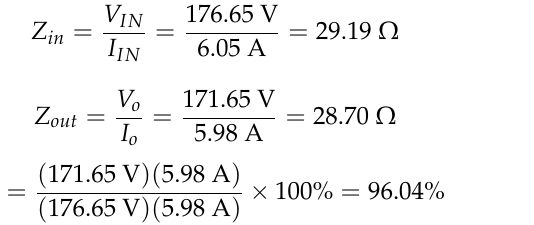
Figure 20. Input voltage (blue), output voltage (blue), input current (red), and output current (green), P o = 1 kW. In Figure 20, an output voltage of 171.65 V rms is obtained for an input voltage of 176.65 V rms , where G V = 0.97 with input and output currents of 6.05 A and 5.98 A, respectively, obtaining G I = 0.988. With the values V in , V o , I in , and I o , the input and output impedances are calculated to determine the multi-resonant circuit efficiency: